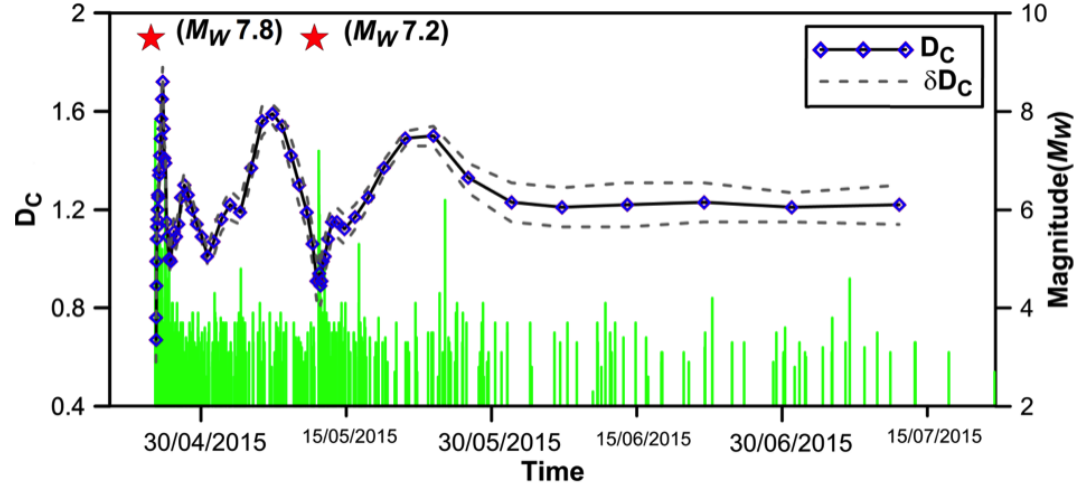
for the studied region. Dashed lines indicate the standard deviation and stars mark the times of occur- Figure 7. Temporal variation of D C ≥ 7. Solid, vertical lines represent the time of occurrence and magnitude (right scale) of all rence of Nepal earthquake sequence for M W recorded earthquakes. Date format: